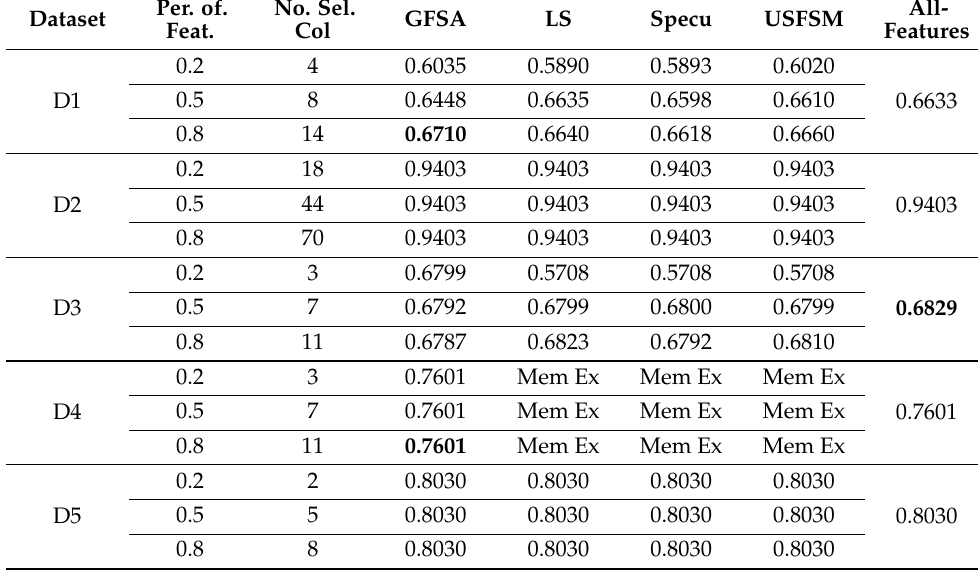
Table 5. SVM accuracy for insurance datasets.